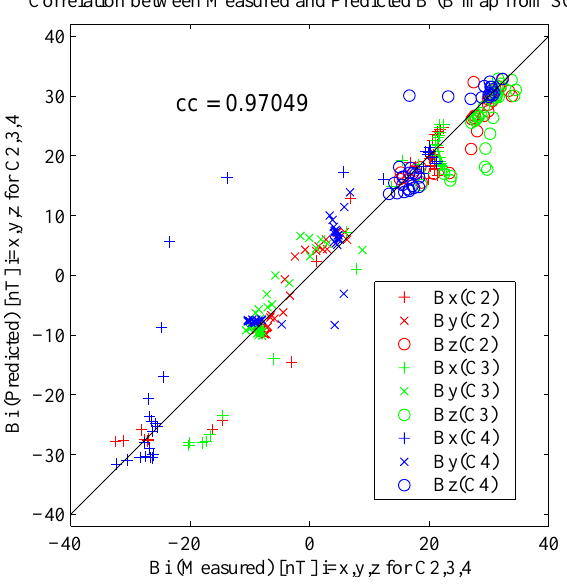
Walen plot for C1 data interval 6:23:23.473−6:23:39.554